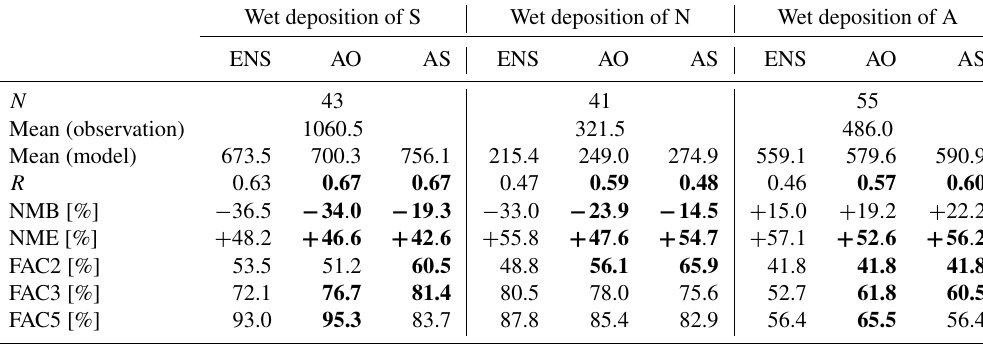
Figure 5. Monthly accumulated precipitation and wet depositions of S, N, and A over Vietnam. Whiskers represent the standard deviation among the seven models, and the wet season (light blue color) is defined as months when precipitation exceeded 50mm. Months shown in red indicate a lack of observational data. Table 6. Statistical analysis of the model performance for four sites in Vietnam. Wet deposition of S Wet deposition of